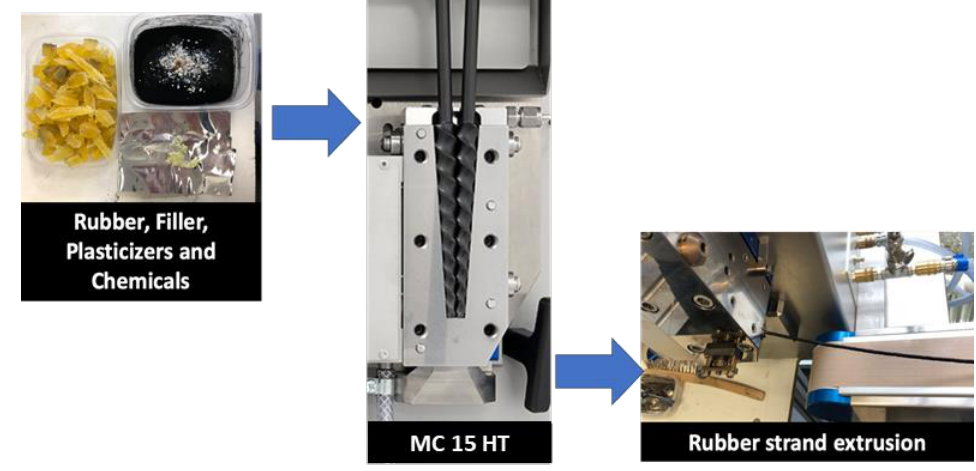
Figure 2. Flow chart of the MC 15 HT compounding.